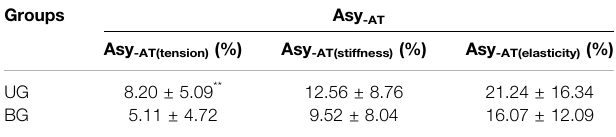
Table 4 . Increased FPI score was correlated to the tone and stiffness of MG in the right side (0.363 per degree, 95% CI: 0.033, 0.146; R 2 (cid:1) 0.132; p (cid:1) 0.004 and 0.28 per degree, 95% CI: 0.256,